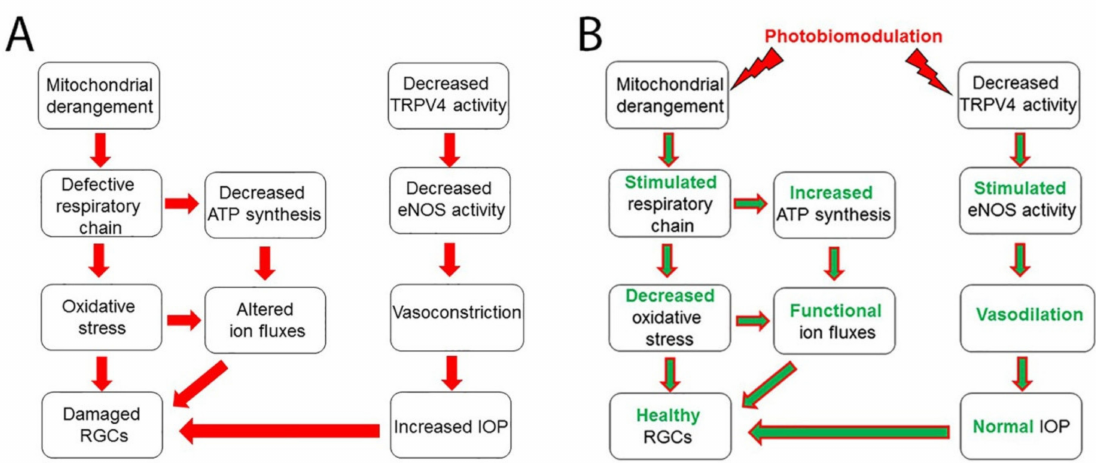
Figure 2. A schematic representation of putative protective effects on cell metabolism in the presence of PBM (Panel B) compared to those in the absence of PBM ( Panel A ). Abbreviation: transient receptor potential vanilloid 4 (TRPV4) cation